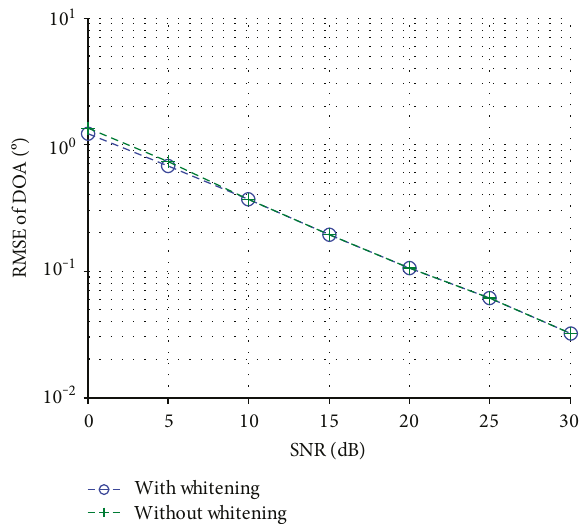
Figure 2: E ff ect of whitening on the DOA estimation error.